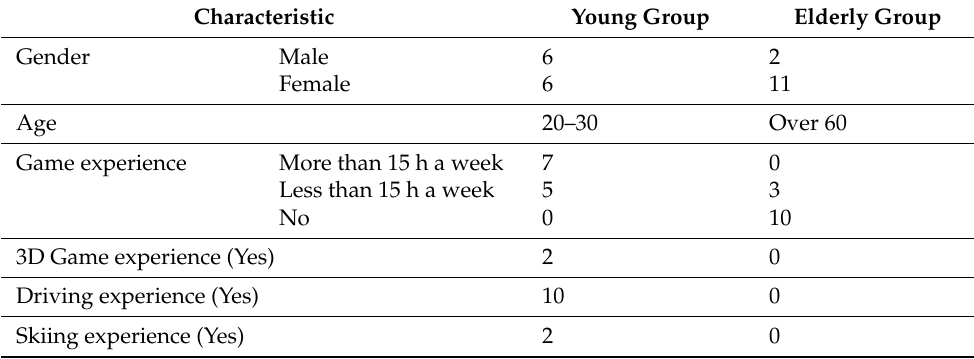
Figure 1. Sample selection. Table 1. Characteristic information of experimental